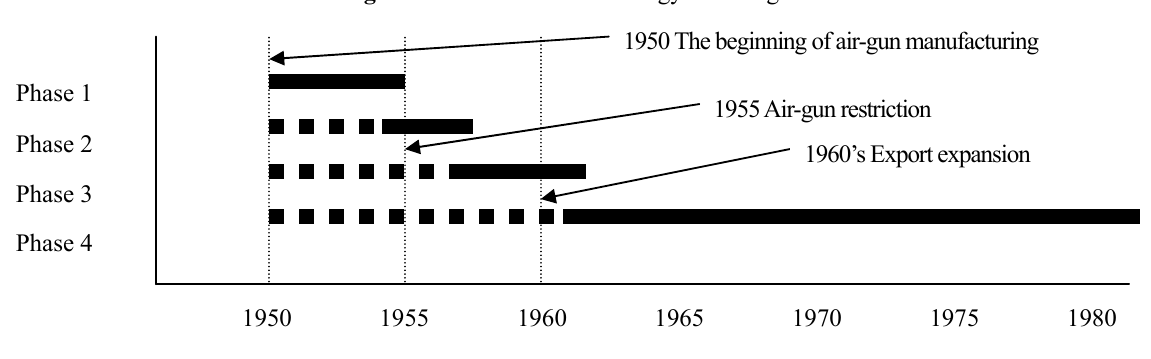
Figure 3. Timeline of Technology